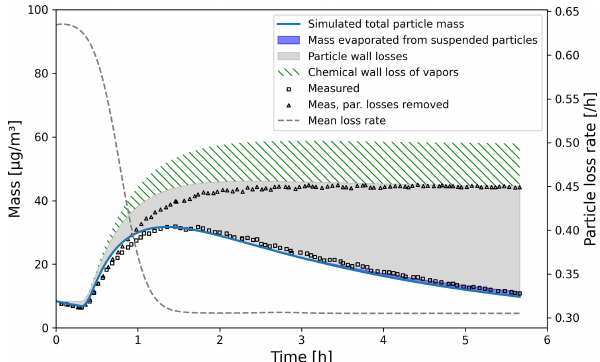
Figure 11. Comparison against α -pinene oxidation experiment (exp. 13, Pathak et al., 2007). Size-resolved aerosol wall losses were measured for the same chamber in Pierce et al. (2008). Moderate chemical wall loss is calculated with parametrization from ARCA box using ALPHAWALL = 5 × 10 − 5 , CW_EQV = 40µmm − 3 and EDDYK = 0 . 05s − 1